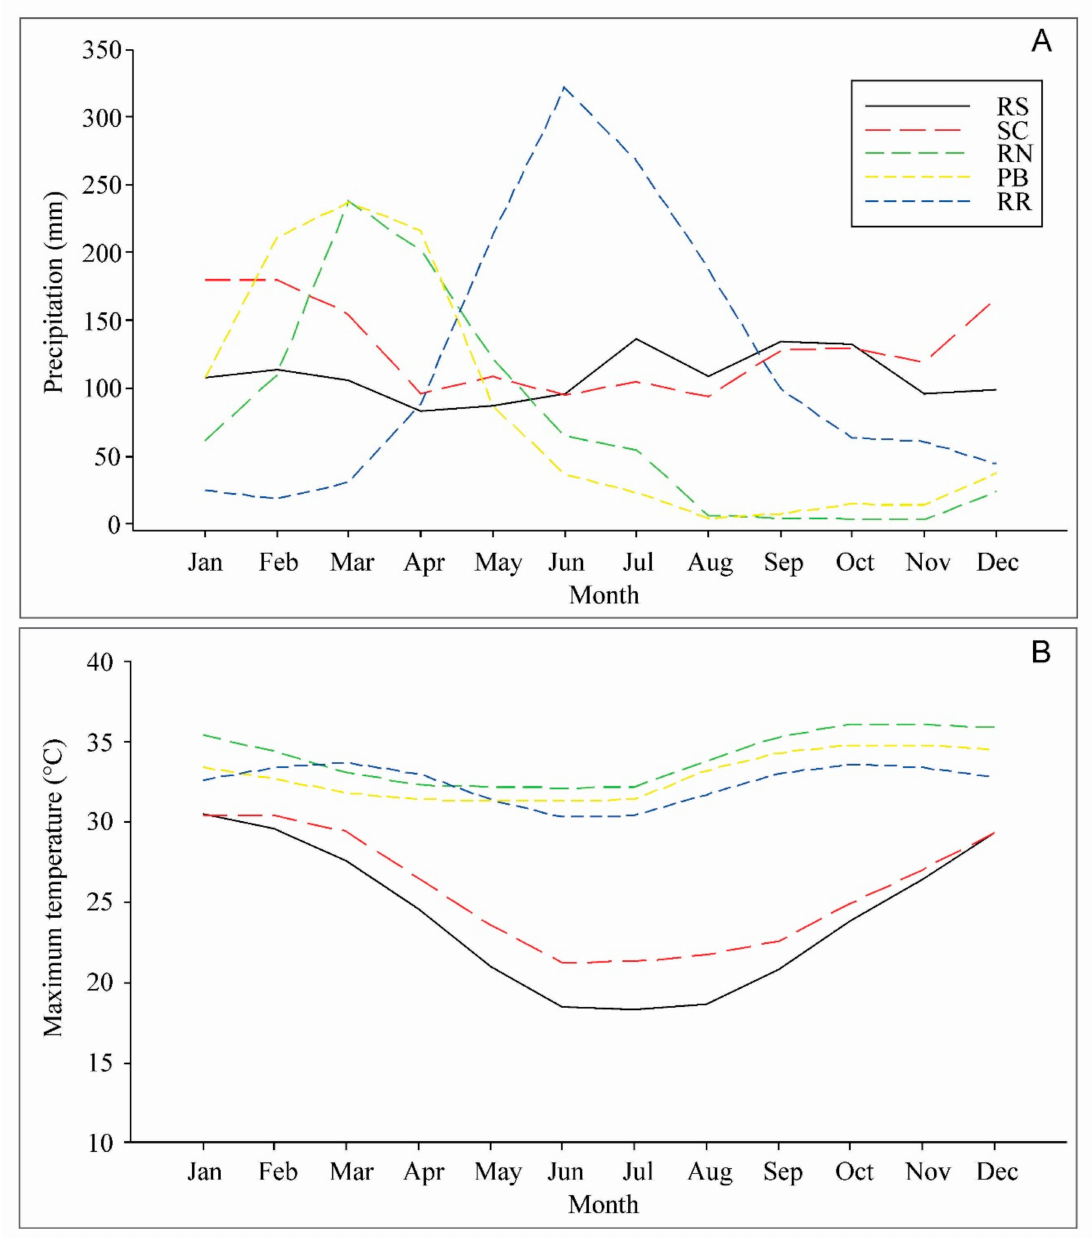
Figure 1. Climatic profile in the regions from where weedy rice accessions and cultivated rice were collected. Average rainfall (mm) ( A ); Maximum temperature ( ◦ C) ( B ). Source: Adapted from Diniz et al.